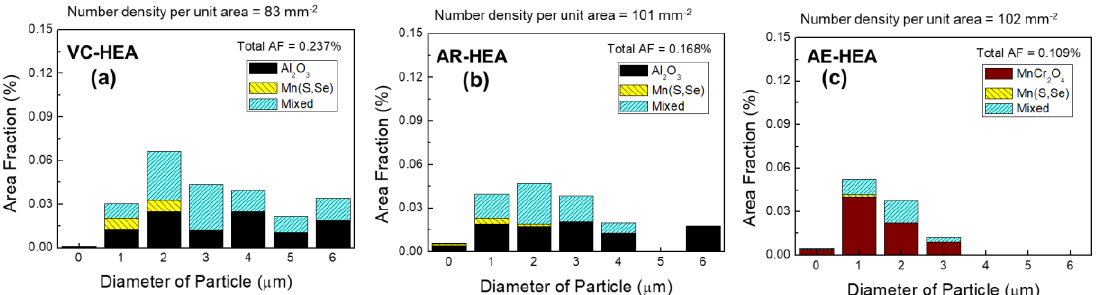
Figure 5. Area fraction of the inclusions classified with type and size in ( a ) VC-HEA, ( b ) AR-HEA, and ( c ) AE-HEA. Total area fraction and number density of inclusions are shown in each alloy system.